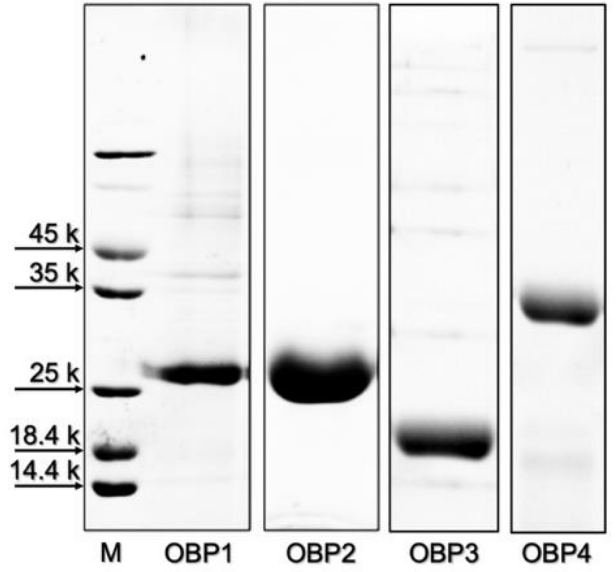
Figure 2. Gel electrophoretic separation under denaturing conditions of the purified samples of the Figure four OBPs of T. urticae used for structural (cysteine pairing) and functional (ligand-binding) charac- terization.